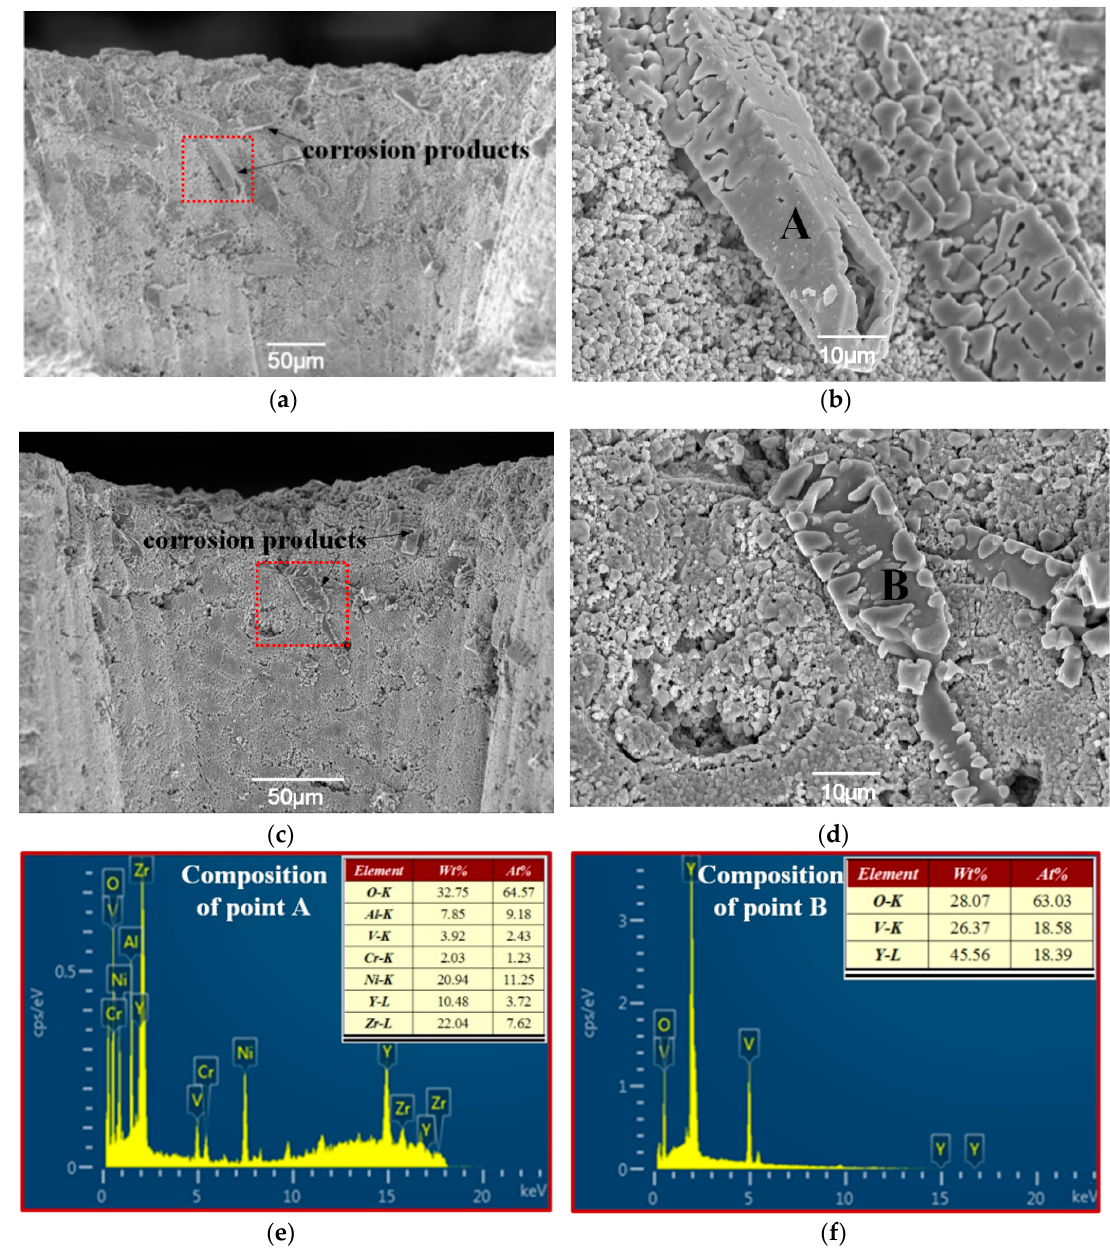
Figure 3. Cross-sectional morphology of the drilled holes: ( a , b ) unrepaired, ( c , d ) repaired with HF-fs laser after exposure to Na 2 SO 4 + V 2 O 5 at 1050 °C for 30 h, ( e , f ) EDS results from points A and B, respectively.